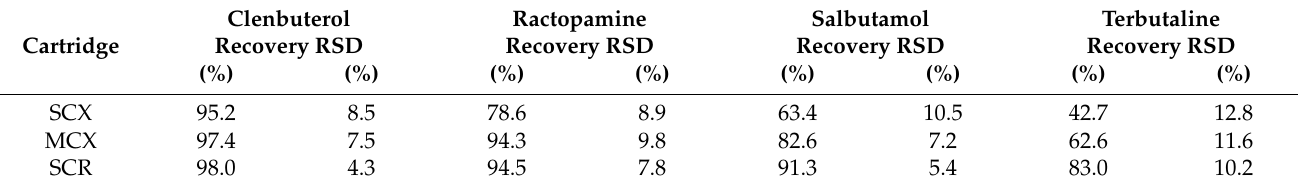
Table 1. SPE recovery results.